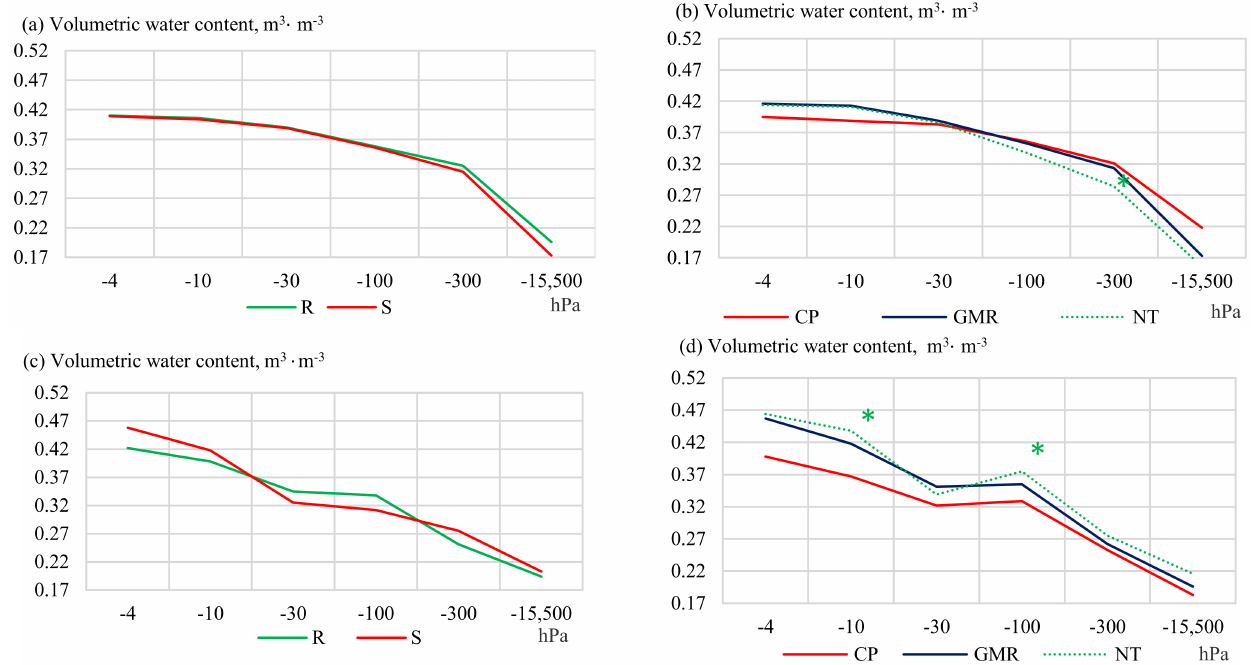
Figure 4. Soil water retention capacity at a depth of 30–35 cm in ( a , b ) 2013 and ( c , d ) 2019. Notes: Significant differences at * p ≤ 0.05 > 0.01; Fisher LSD test vs. control. Other explanations are given